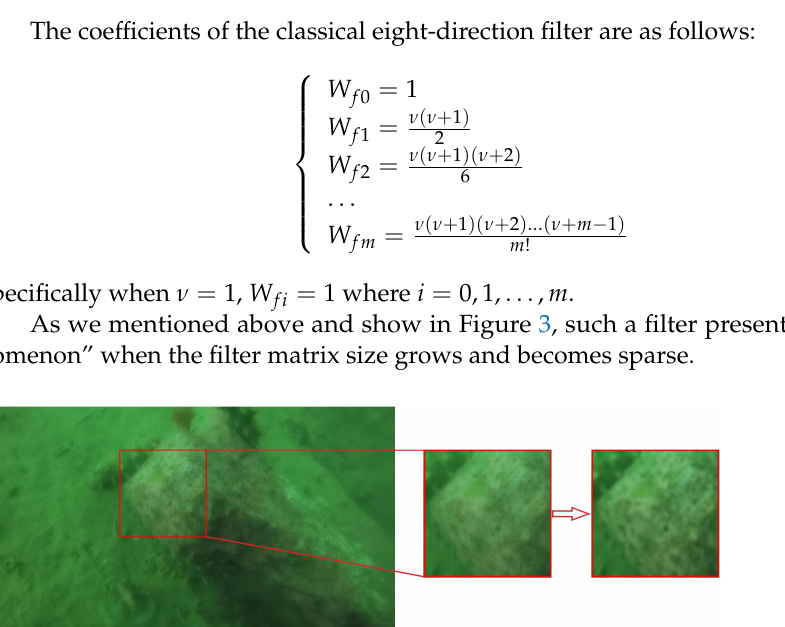
Figure 2. The classical 8-direction fractional integral filter on a 2-D grid.